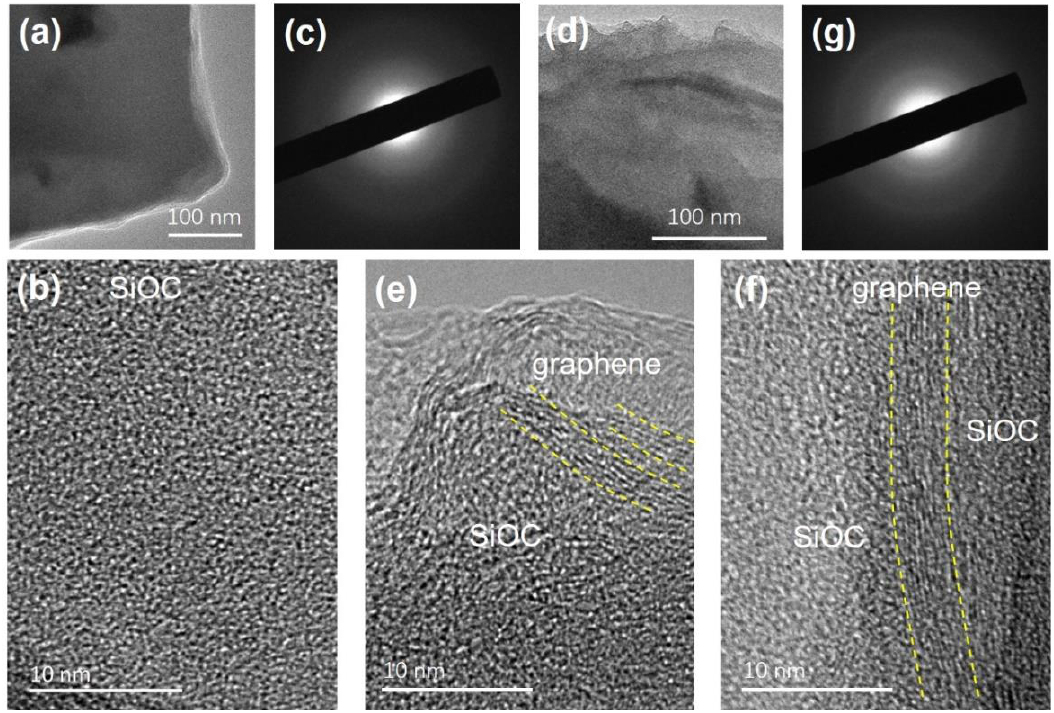
Figure 3. ( a ) TEM, ( b ) HRTEM, and ( c ) SAED images of SiOC sample. ( d ) TEM, ( e , f ) HRTEM, and ( g ) SAED images of RGOA-1000/SiOC nanocomposite.